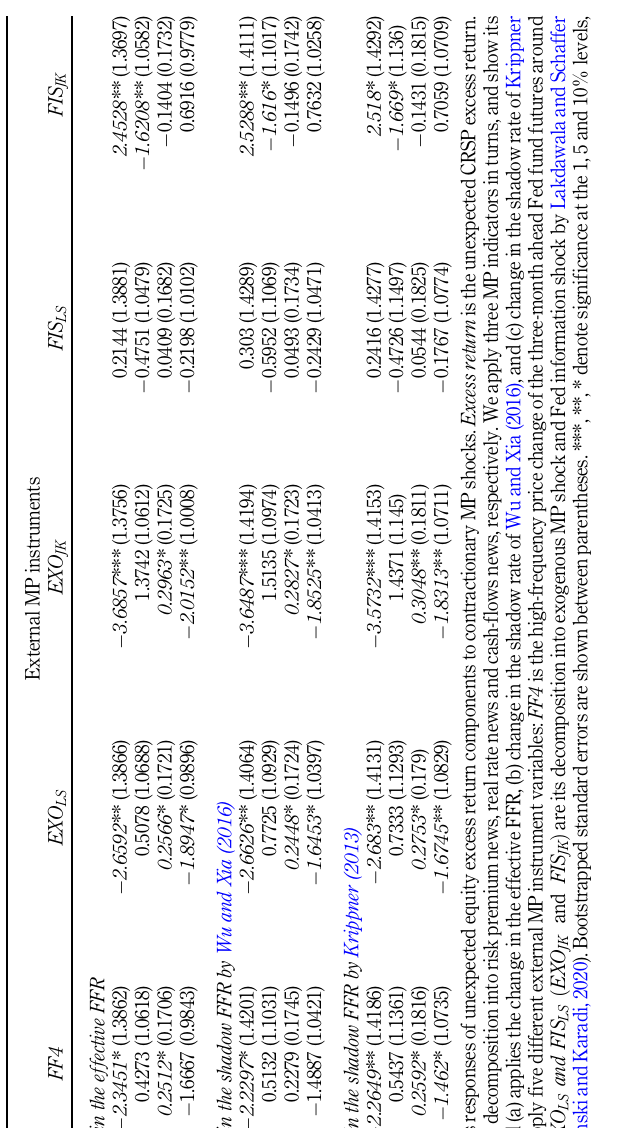
Table 5. Responses